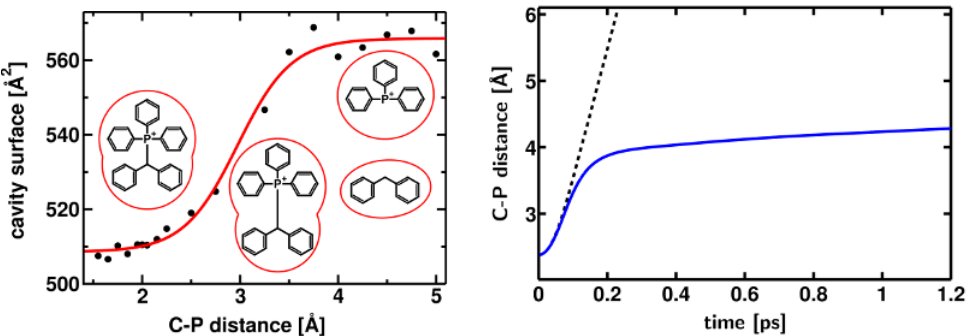
Fig. 2. Cavity surface area plotted against C-P distance (black dots, left) together with the fitted sigmoid shape function (solid line). Expectation value of the C-P distance during the bond cleavage process in the phenylmethyl-phenylphosphonium ion (right). The propagation was performed in one dimension along the minimum energy path in the ground state with (solid line) and without (dashed line) the dynamic continuum